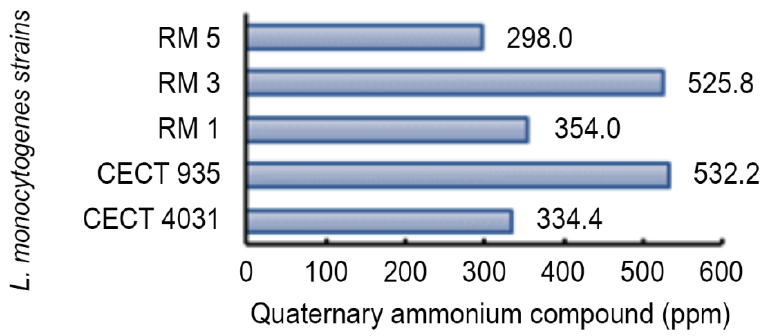
Figure 6. LD 90 estimated values of L. monocytogenes tested strains in biofilm exposed to QaC.